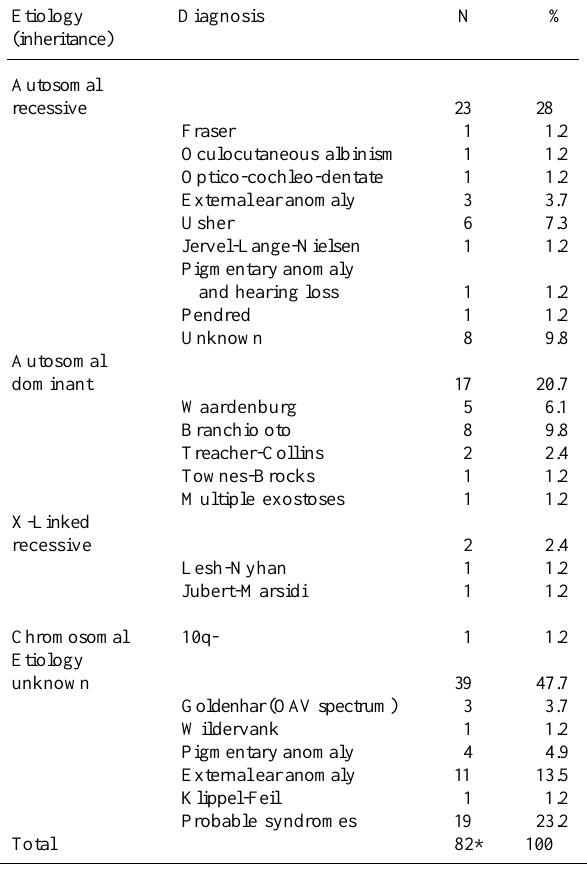
Table II - Probable etiological diagnosis of associated hearing loss among 82 patients of 76 families. Etiology Diagnosis N % (inheritance) Autosomal